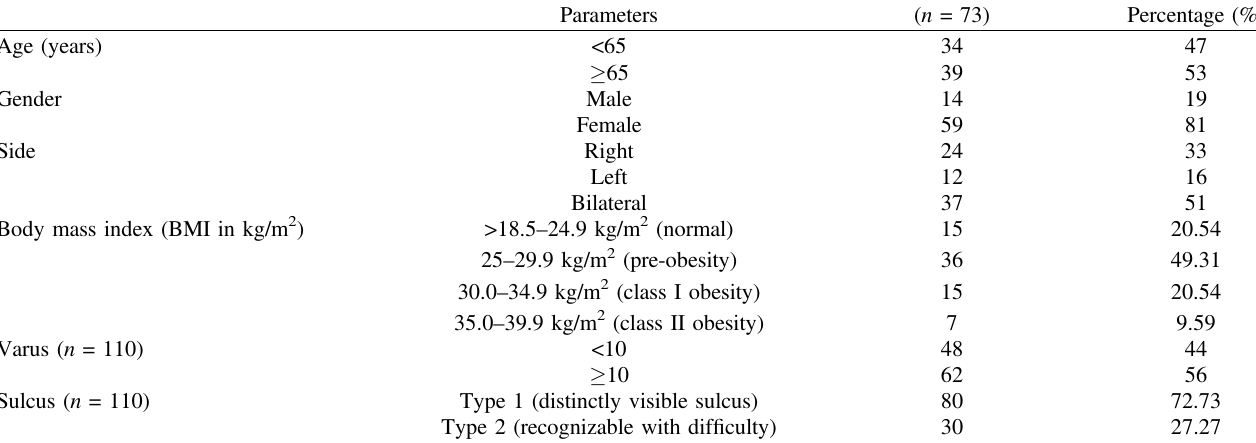
Table 1. Demographic data.